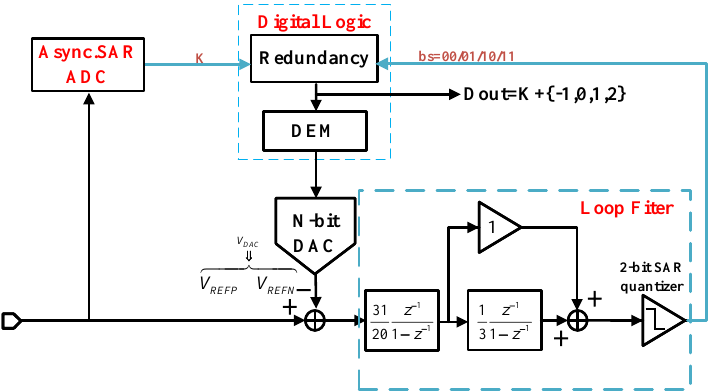
Figure 1. Block diagram of the zoom ADC with 2-bit second-order loop filtering and a coarse asynchronous